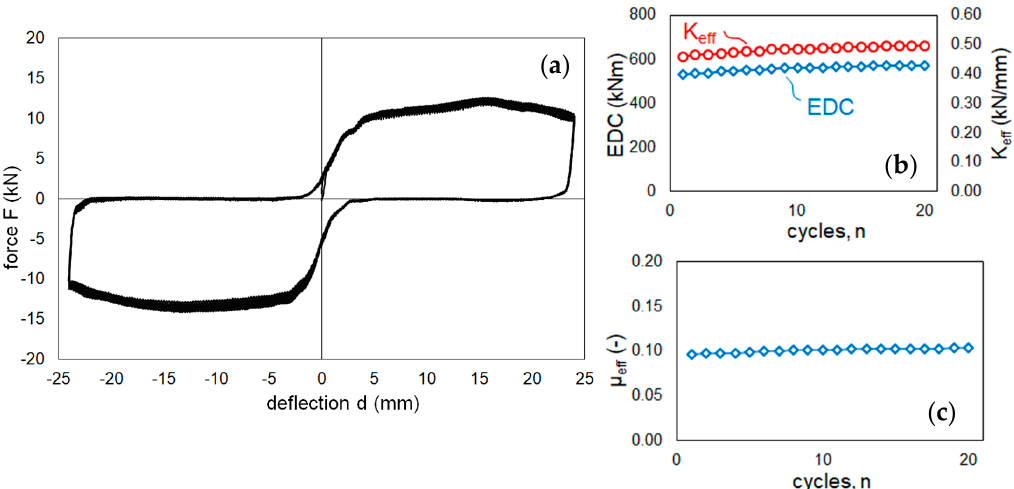
Figure 12. Dynamic test D3: ( a ) horizontal force–deflection diagrams; ( b ) change of Effective stiffness K eff and energy dissipated per cycle EDC with the number of cycles; ( c ) change of effective coefficient of friction μ eff .